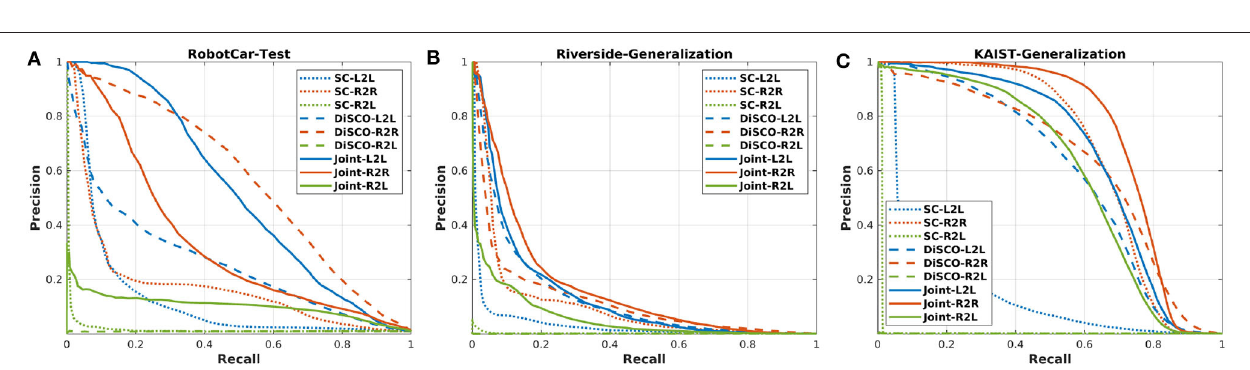
FIGURE 5 | (A) The ground truth based binary matrix, where the black points are the loops. (B) The R2R based similarity matrix generated using the proposed method. (C) The loops closure detection result under certain threshold, and the blue lines are the detected loops. Note that a growing height and a color-changing are added to each pose with respect to the time for visualization.